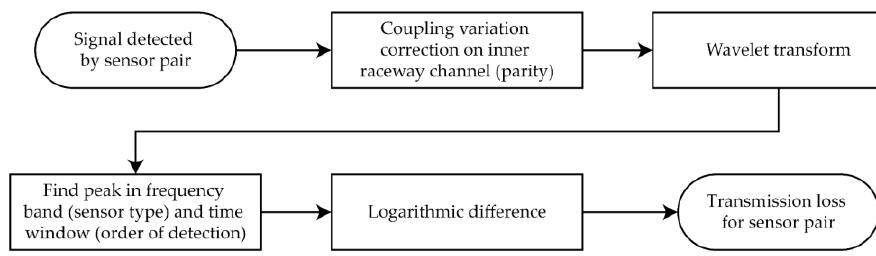
Figure 3. Overview of procedure for data processing.